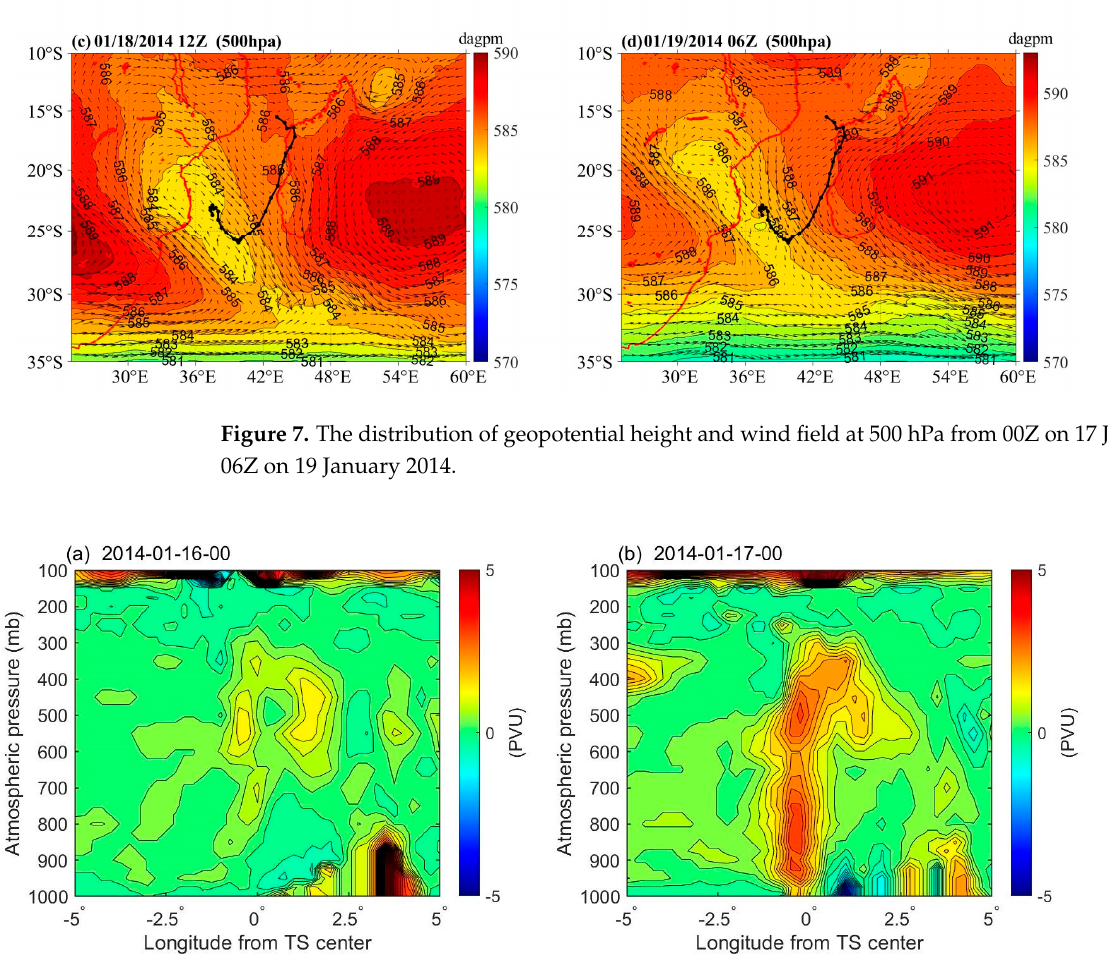
Figure 8. The change in the zonal vertical cross-section of the PV of ± 5 longitude over the TS cen- ter during TS development on ( a ) 00:00 UTC Jan 16, ( b ) 00:00 UTC Jan 17, ( c ) 00:00 UTC Jan 18, ( d ) 00:00 UTC Jan 19, (unit: PVU, 1PVU = 106 K m 2 kg − 1 s − 1 ). 5. Conclusions This study analyzed the effects of anticyclonic eddies on the unique tropical storm Deliwe’s (2014) intensity and track in the Mozambique Channel based on multisource re- analysis, CTD and Argo data. The detailed conclusions are as follows: (1) The mesoscale eddies in the Mozambique Channel had an important influence on the development of the TS. The anticyclonic eddy W1 supported the development of Deliwe. At 0:00 on 16 January, the TS left Madagascar Island and entered the Mozambique Channel. Subsequently, at 0:00 on 17 January, the positive vorticity column was elongated, and the PV center was located in the middle and lower atmosphere. The maximum PV at 700 mb was 3.39 PVU. On 17 January, the maximum average latent heat flux on the anti- cyclonic eddy W1 reached 103.1 W/m 2 ; (2) During the development of the TS, the MLD in the Mozambique Channel was significantly deepened, especially for the anticyclonic eddies. The MLD in W1 and W2 increased by 40.34 m and 55.75 m, respectively. The deepened mixed layer obstructed the upwelling of cold water and allowed the ocean to provide more energy to the TS; (3) The atmospheric system with high levels of center divergence and low levels of convergence provided an advantageous environment for Deliwe to strengthen, but the TS intensity decreased significantly in the southern channel at 00Z on 18 January 2014. The subtropical high began to tear on the 17th, and the center of the lower level moved over anticyclonic eddy W2 on the 18th. Deliwe had a large deflection to the northwest due to the combined effect of the westerly trough and atmospheric pressure gradient. Author Contributions: Conceptualization, L.B., H.L. and S.M.I.; methodology, L.B., H.L., X.D. and H.H.; validation, L.B., H.L., X.D. and H.H.; formal analysis, L.B., H.L., S.M.I., X.D. and Y.Z.; inves- tigation, L.B., Y.Z., S.M.I., H.L. and X.D.; resources, L.B., H.L. and S.M.I.; data curation, L.B. and